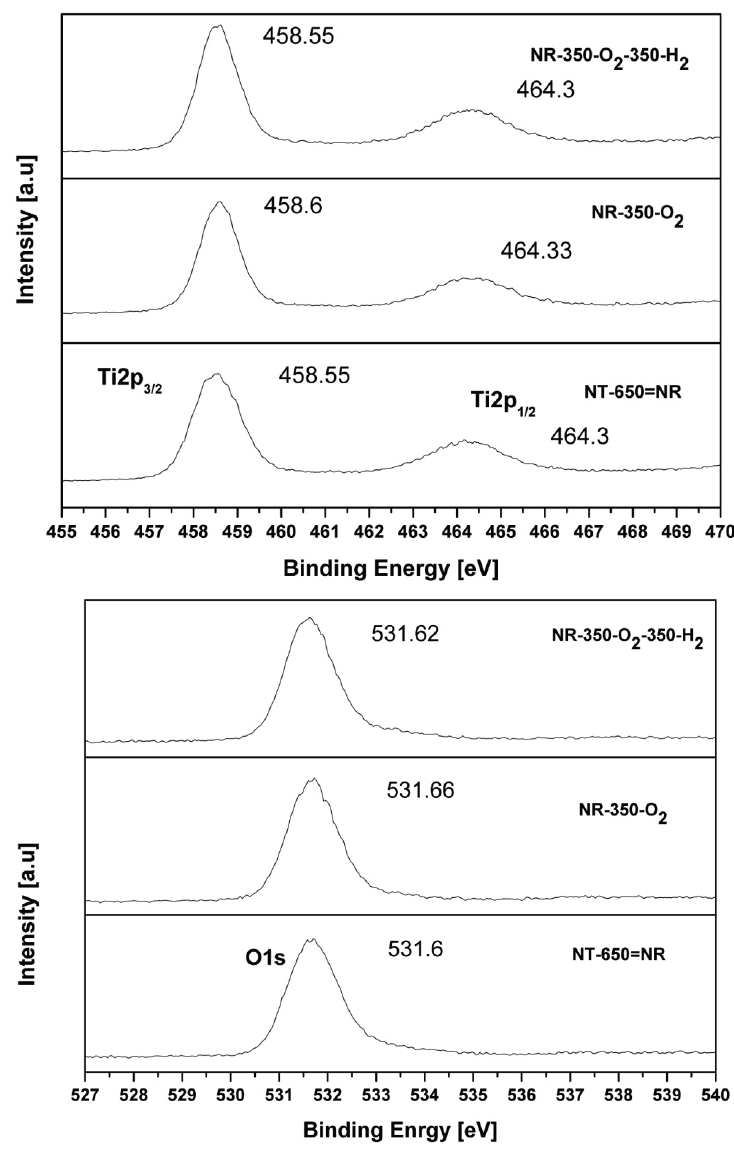
Figure 5. The XPS spectra for ( top panel ) Ti 2p and ( bottom panel ) O 1s for the cTiNTs which have been subjected to different pre-treatments: ( bottom trace ) cTiNT; ( middle trace ) cTiNT-O 2 ; ( top trace ) cTiNT-O 2 -H 2